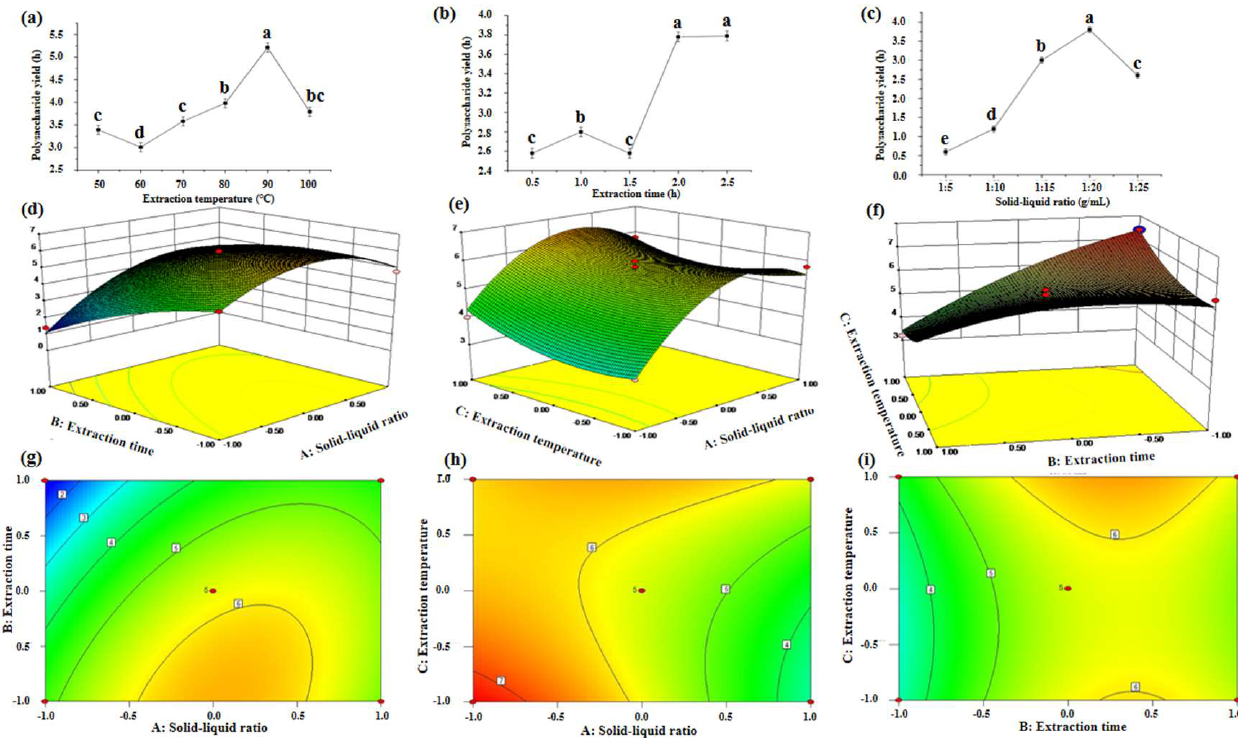
Figure 1. Effects of different single-factor conditions, including the extraction temperature ( a ), extraction time ( b ), and solid-liquid ratio ( c ) on the CDTPS yield. Response surface plots for ( d , g ) Y = f (B, A), ( e , h ) Y = f (C, A), and ( f , i ) Y = f (C, B).